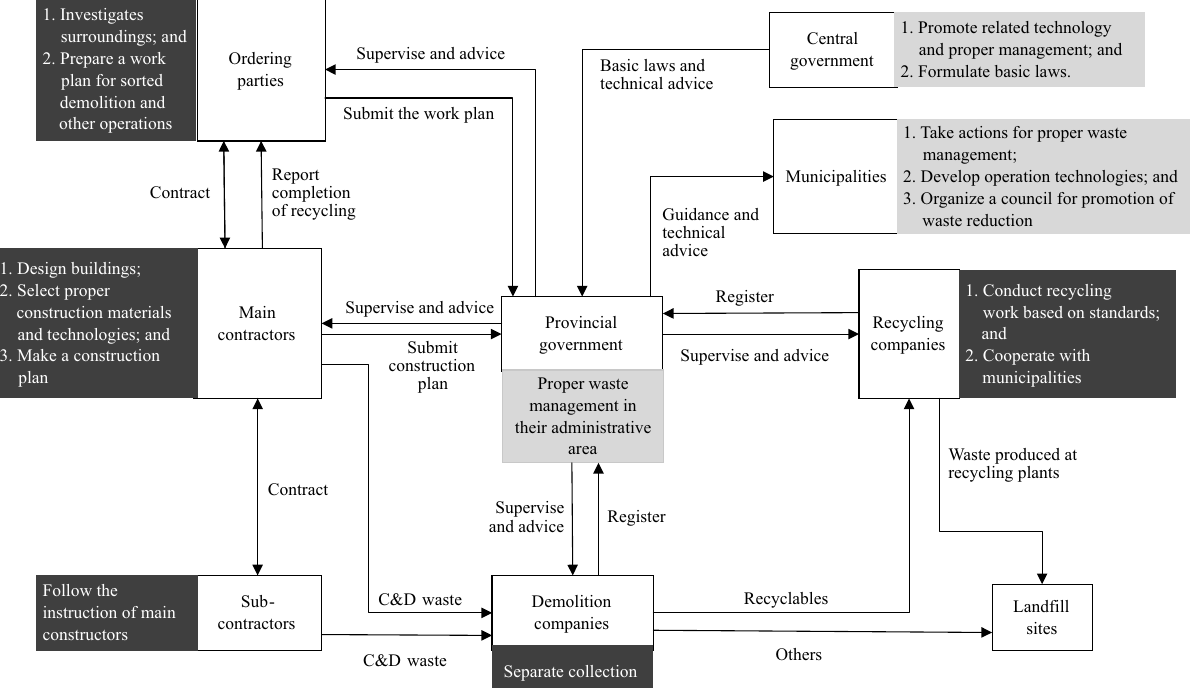
Figure 3. Responsibilities of related stakeholders in Japan (based on Ministry of the Environment,